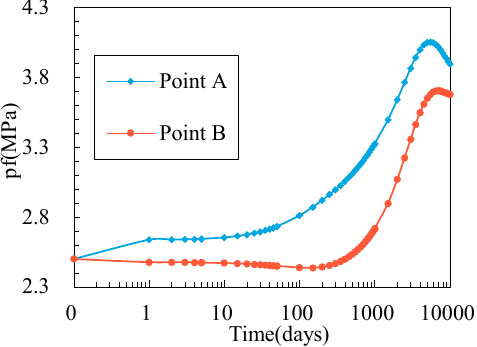
Figure 9. Evolution of the total pore pressure in matrix at Point A and Point B. Point A is close to the IW and Point B is close to the PW.